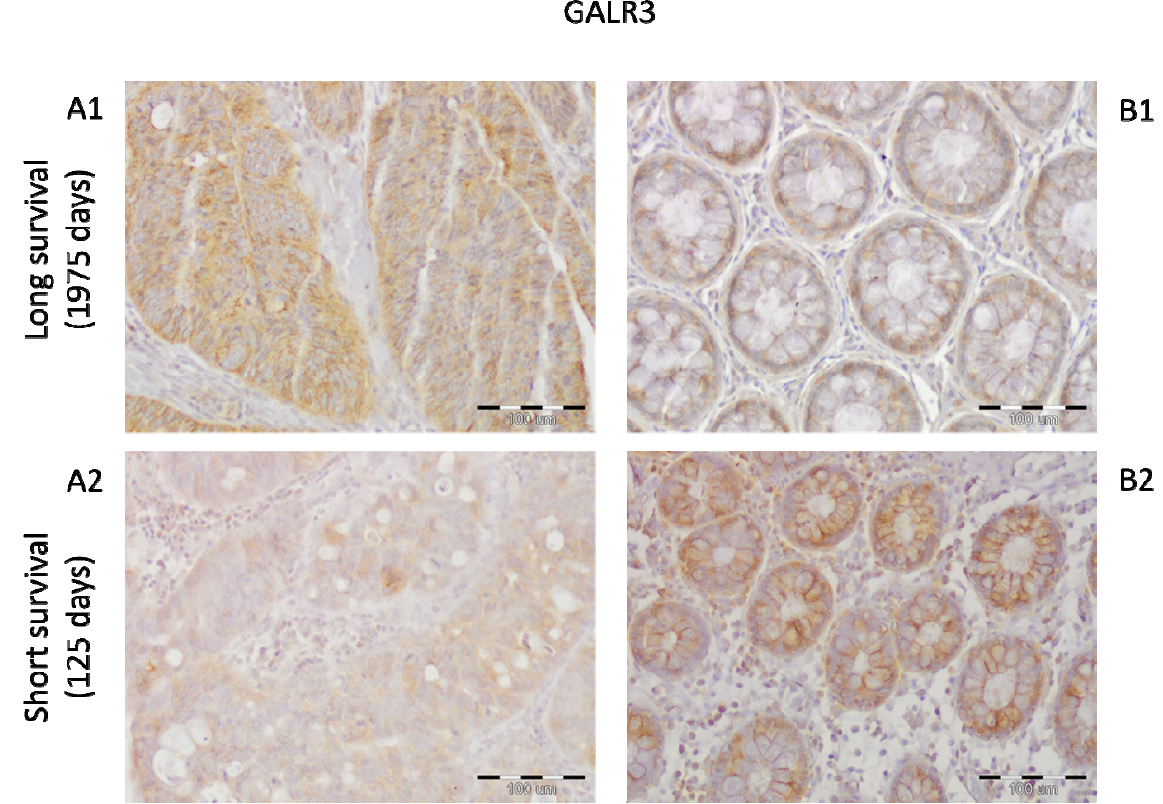
Figure 6. Immunoexpression of the GalR3 protein in colorectal cancer tissue ( A ) and epithelial cells of unchanged mucosa ( B ) of a colorectal cancer (CRC) patient with long survival and better prognosis (( A1 , B1 ), respectively) and a CRC patient with shorter survival and poorer prognosis (( A2 , B2 ), respectively). The data shown here are representative of 10 slides of CRC and unchanged tissue. Total magnification: 200 × , the size of the scale bar in the figure is 100 µ m for each photograph.